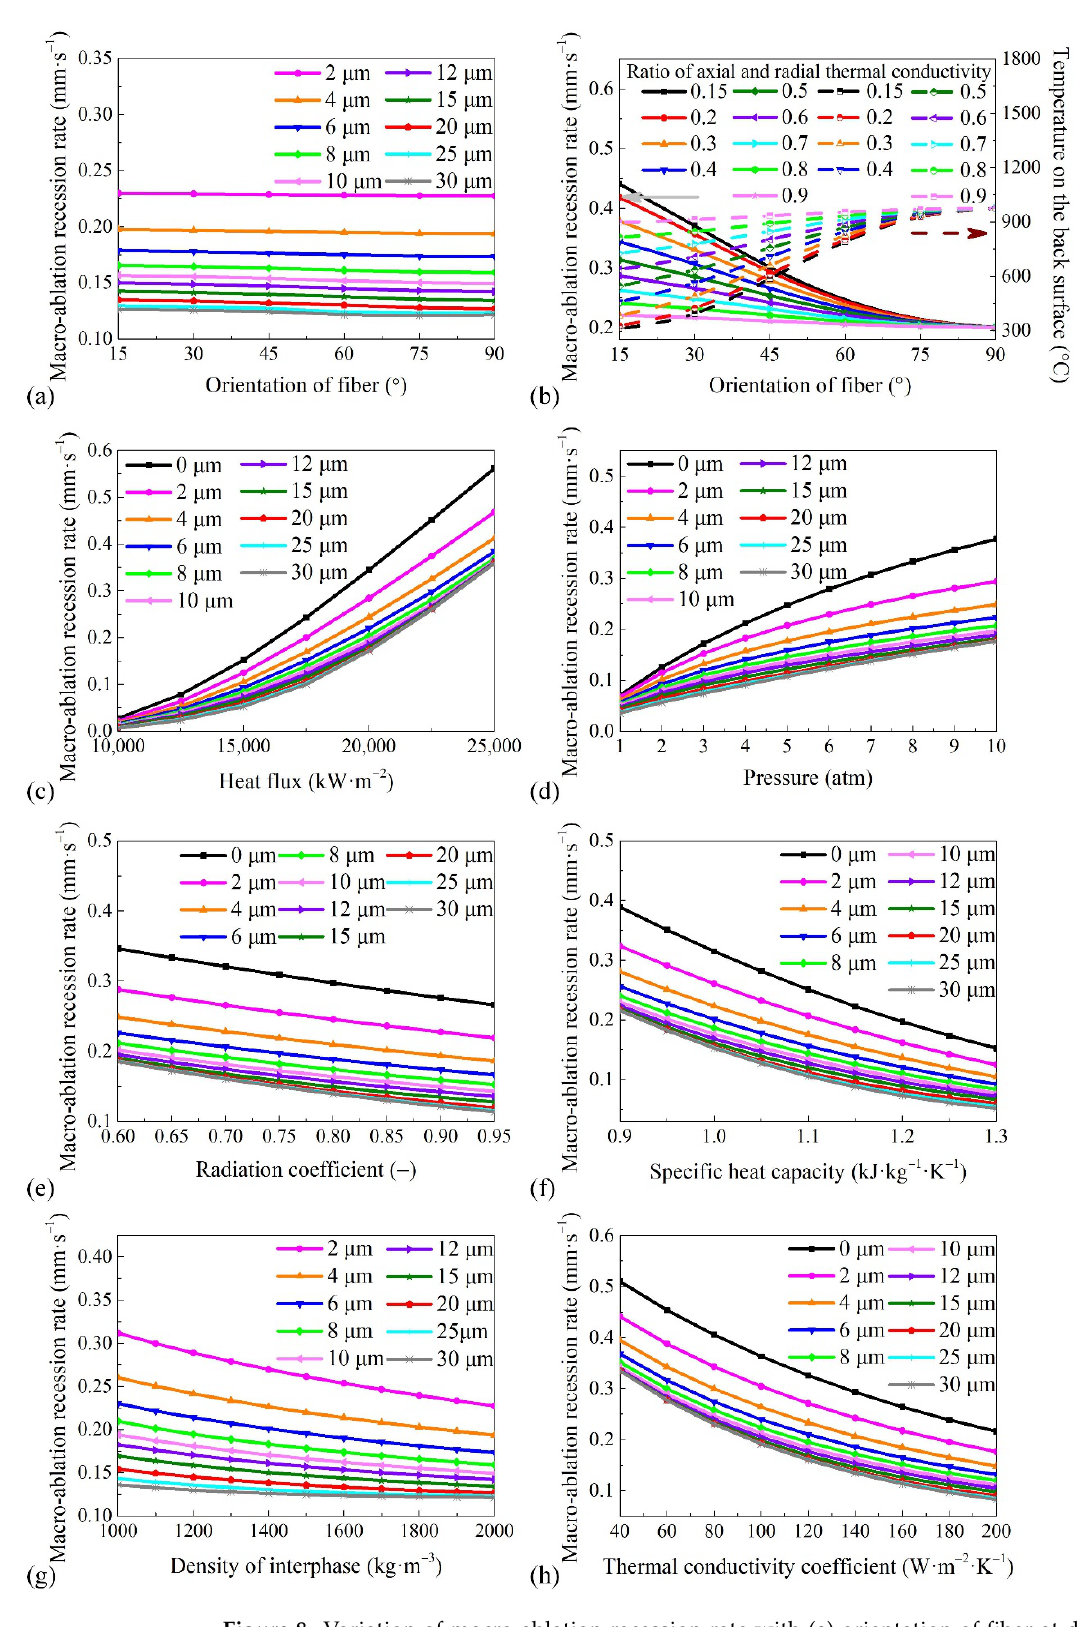
Figure 8. Variation of macro-ablation recession rate with ( a ) orientation of fiber at different fiber radii ( R = 0, 2, 4, 6, 8, 10, 15, 20, 30 μm); ( b ) orientation of fiber at different radial and axial thermal conductivity ratios ( λ 1 / λ 2 = 0.15, 0.2, 0.3, 0.4, 0.5, 0.6, 0.7, 0.8, 0.9); ( c ) heat flux; ( d ) pressure; ( e ) radiation coefficient; ( f ) specific heat capacity; ( g ) density of interphase; and ( h ) thermal conductivity coefficient.